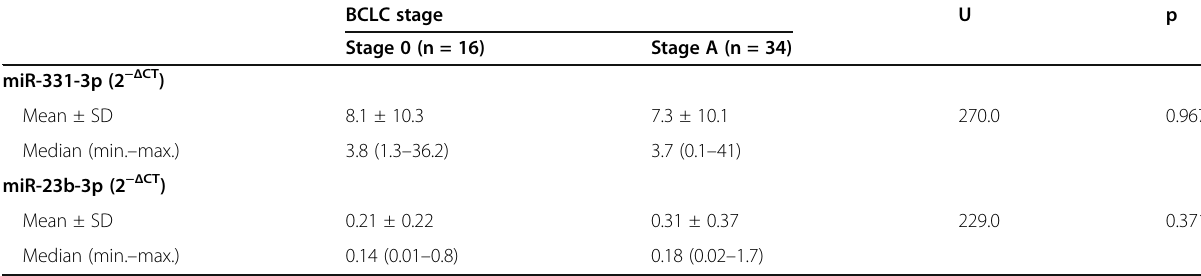
Table 2 Plasma concentrations of miR-331-3p and miR-23b-3p in group II (n = 50) BCLC